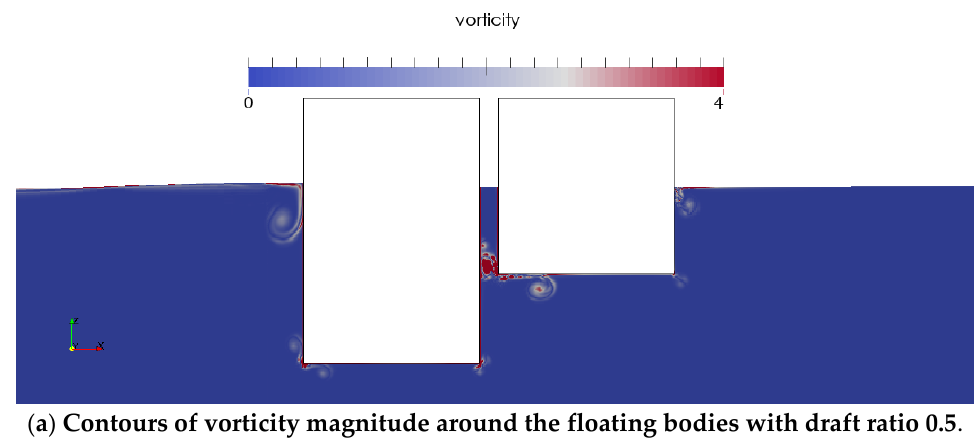
( a ) Contours of vorticity magnitude around the floating bodies with draft ratio 0.5 .